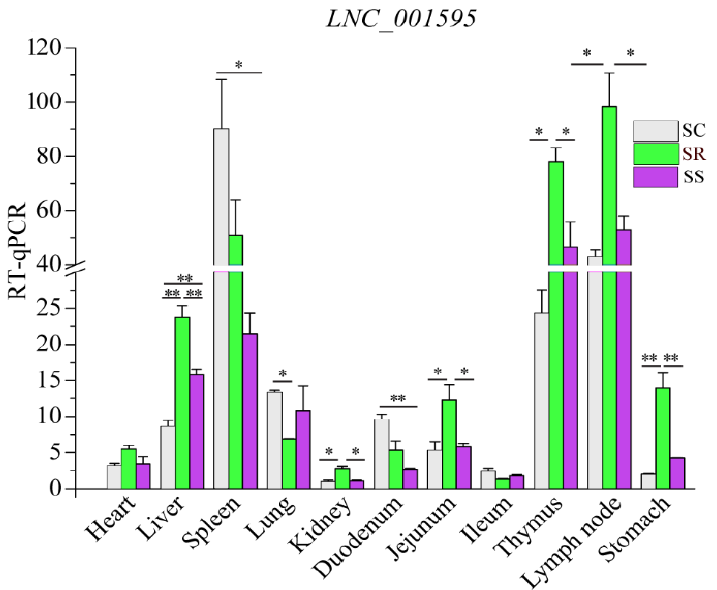
Figure 9. Relative expression of LNC_001595 in different tissues. The results are shown as Mean ± SE with three duplicates. One-way ANOVA was conducted to calculate statistical significance followed by Duncan’s test. Different asterisks above bars indicate significant differences (* p < 0.05, ** p < 0.01).